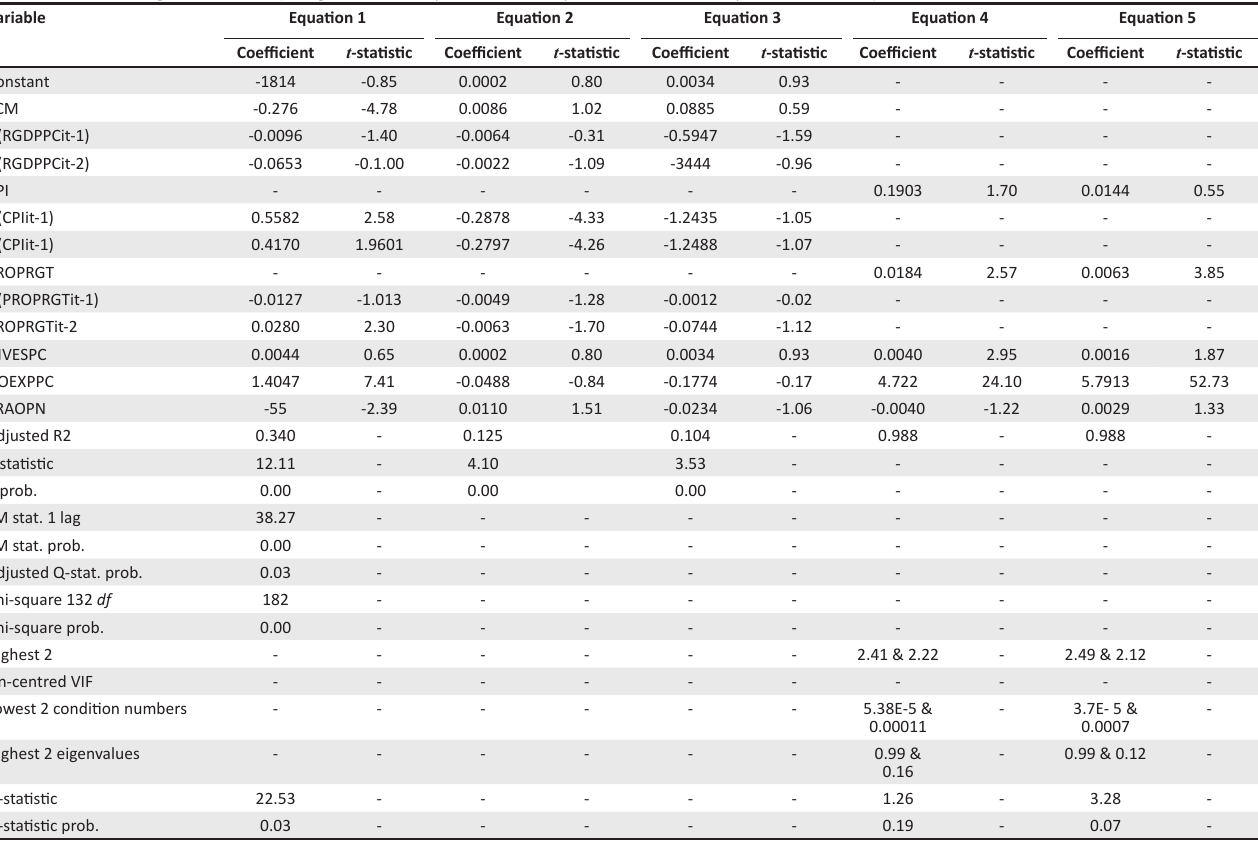
TABLE 4: Panel data regression results (real gross domestic product is the dependent variable, except Models 2 and 3).